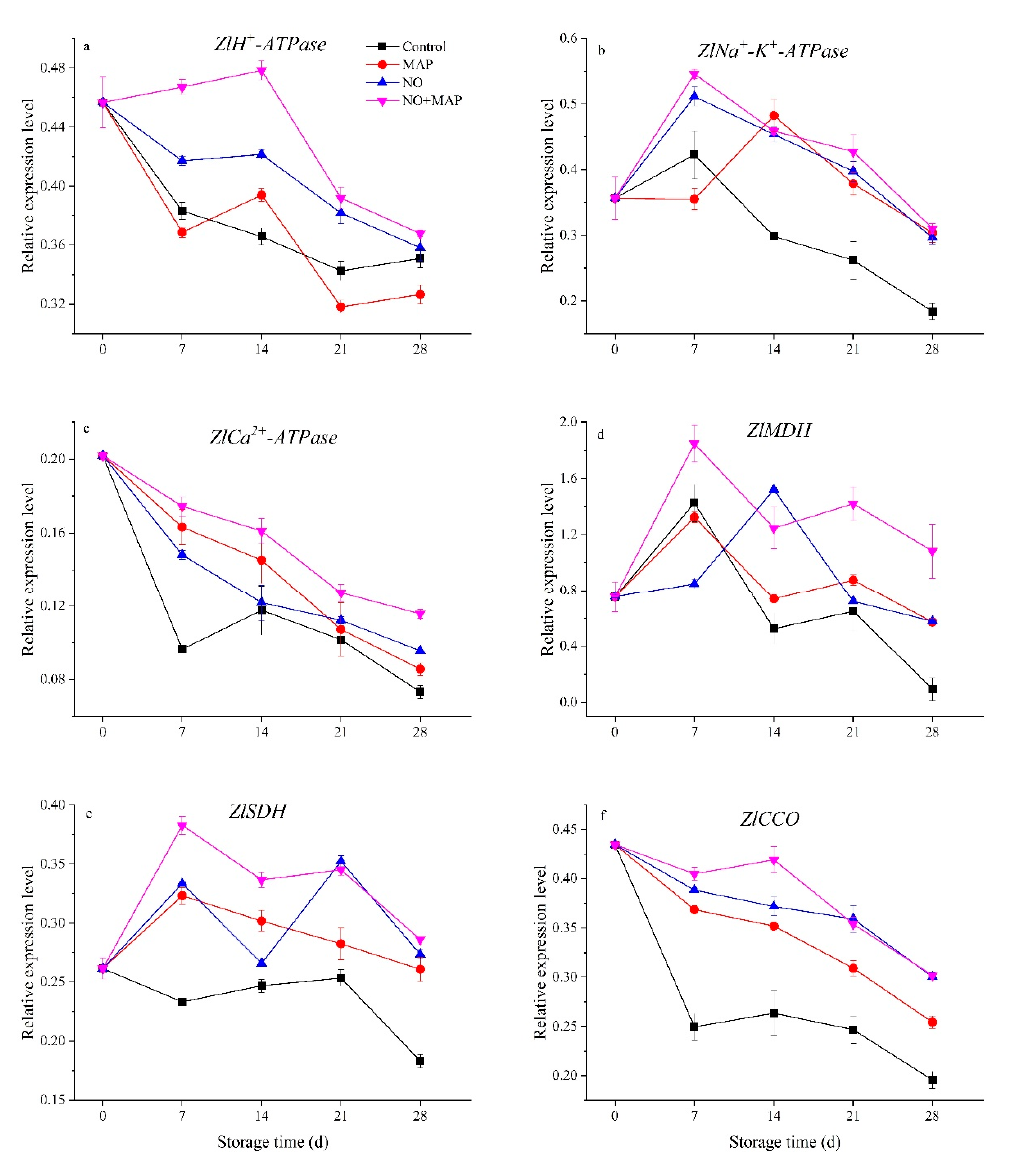
Figure 7. Effects of NO and MAP treatment on the expression of ZlH + - ATPase ( a ), ZlNa + -K + - ATPase ( b ), ZlCa 2+ - ATPase ( c ), ZlMDH ( d ), ZlSDH ( e ), and ZlCCO ( f ) in water bamboo shoots stored at 4 °C for 0, 7, 14, 21, and 28 d. Values are presented as mean ± SD.